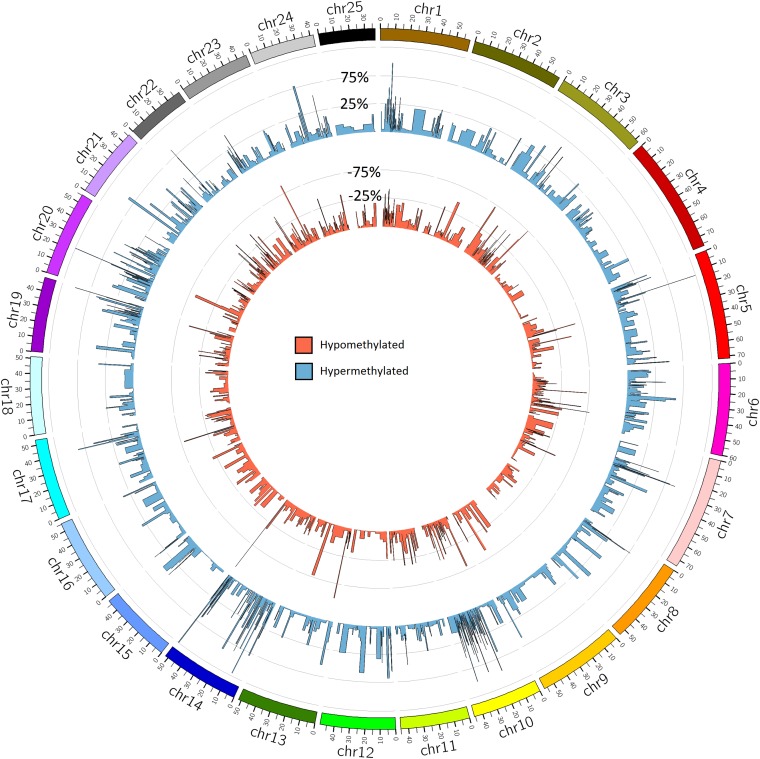
Global methylation patterns in zebrafish embryos exposed to 10 μM BPA from 24 to 96 hpf. Differentially methylated regions in zebrafish embryos exposed to BPA compared to controls. The blue circular bar plot represents percent of hypermethylation and the red circular bar plot shows percent of hypomethylation per region (Q-value <0.01 and methylation difference >25%). DM regions in this figure are mean DM per 10 Mbp window.